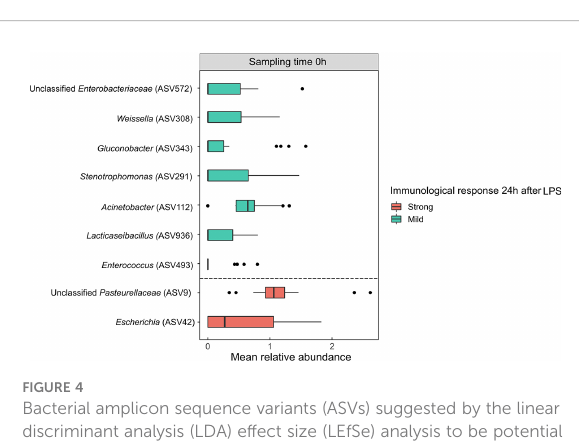
FIGURE 4 Bacterial amplicon sequence variants (ASVs) suggested by the linear discriminant analysis (LDA) effect size (LEfSe) analysis to be potential predictors of the strength of the immune response. ASVs which differed signi fi cantly between bats with mild and strong immune responses at time 0h, as con fi rmed by LEfSe ( p <0.05, LDA score>2.0), are presented. The bars are colored according to bat haptoglobin production category 24h after the administration of the LPS challenge, and ASVs predicted to cause a strong immune response are separated from those predicted to cause a mild immune response by a dashed line. Results are presented as mean ± SEM. LPS, lipopolysaccharides.